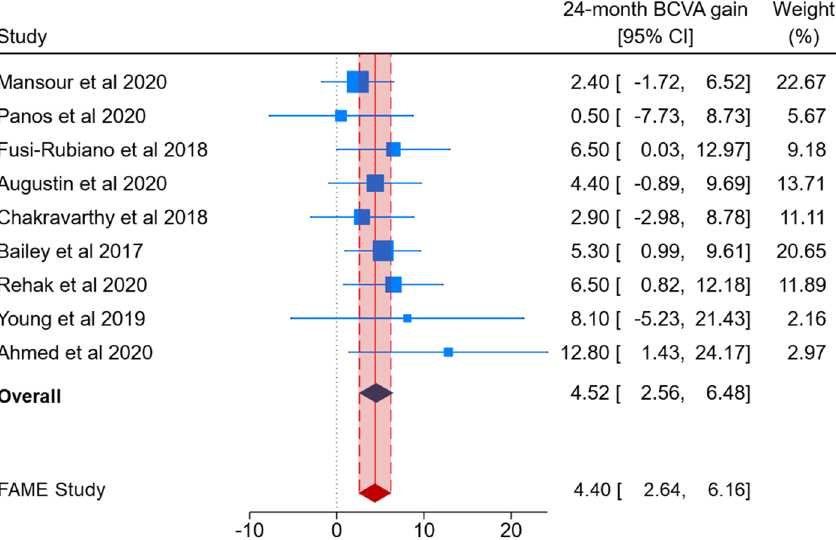
Figure 2. A forest plot showing 24-month best corrected visual acuity (BCVA) gain, reported as Mean Difference (MD) with 95% confidence interval (CI), in real-world studies and 24-month BCVA gain in the FAME study.